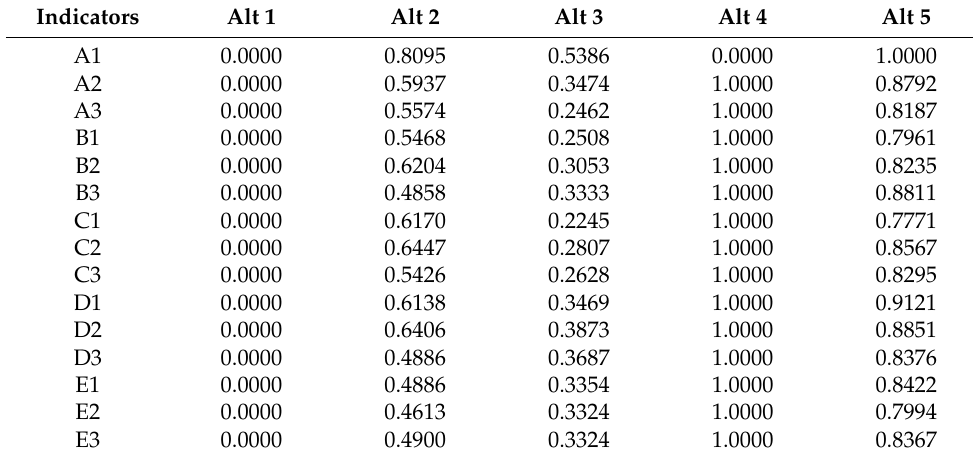
Table 14. Normalised data.